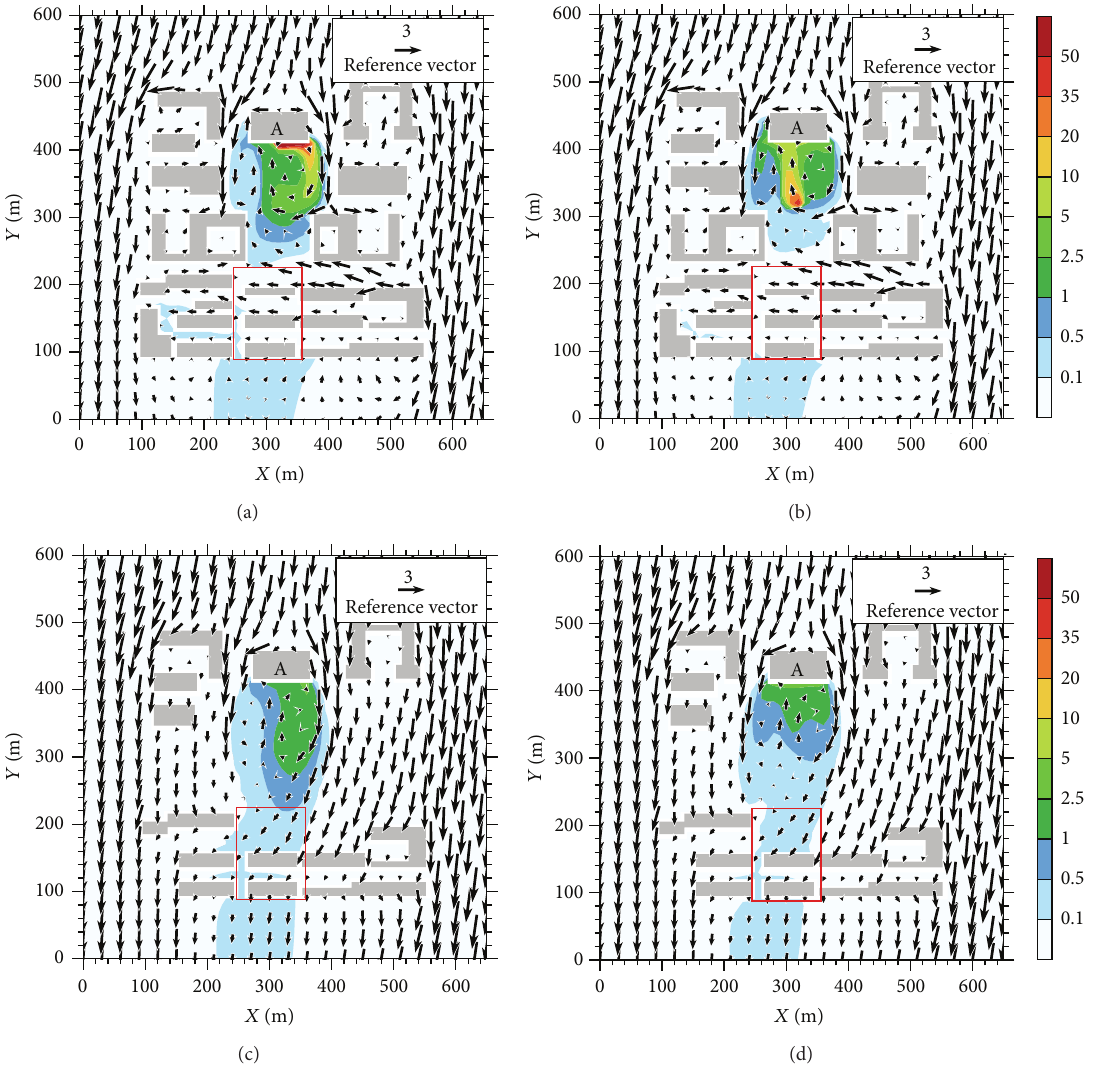
Figure 10: Simulated concentration (ppm) and wind vector fields at 1400 LST on 13th of August: (a, b) at 𝑧 = 2.5 m; (c, d) at 𝑧 = 22.5 m; (a, c) the point source was located at P1; (b, d) the point source was located at